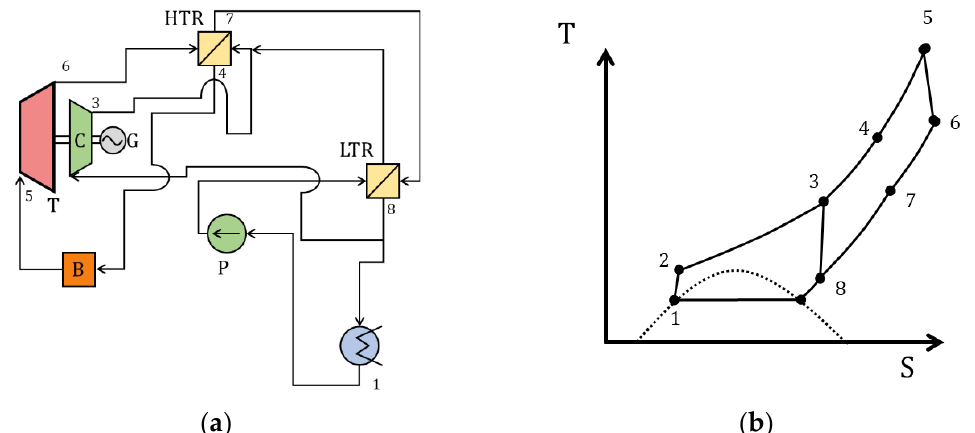
Figure 8. Rankine cycle with recompression: ( a ) schematic diagram; ( b ) T–S diagram [13]. B—boiler;